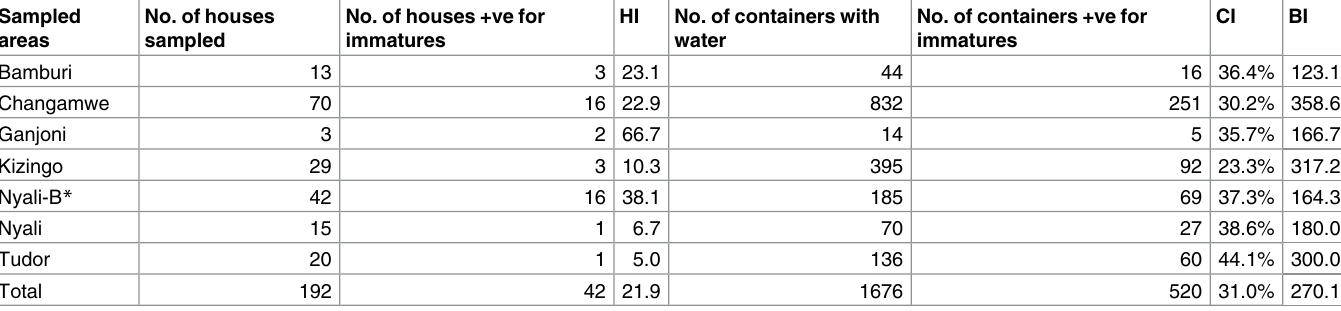
Table 3. Overall and site-specific House, Container and Breteau indices for Mombasa city during the outbreak. Sampled No. of houses areas